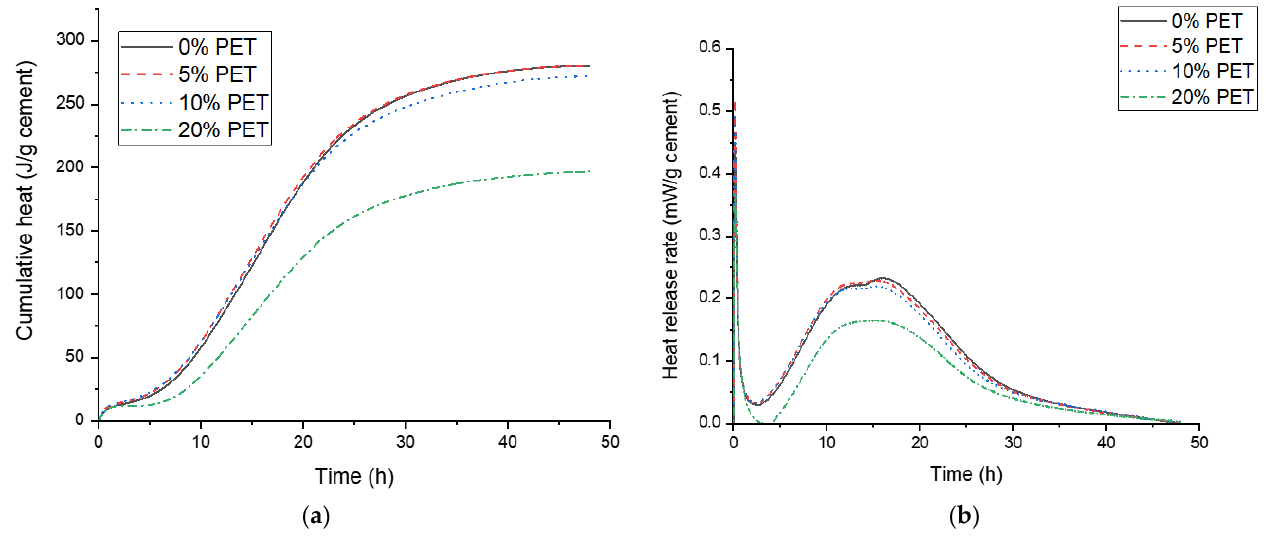
Figure 5. Isothermal calorimetry results of cement paste samples incorporating PET powder. ( a ) Cumulative heat and ( b ) heat release rate.